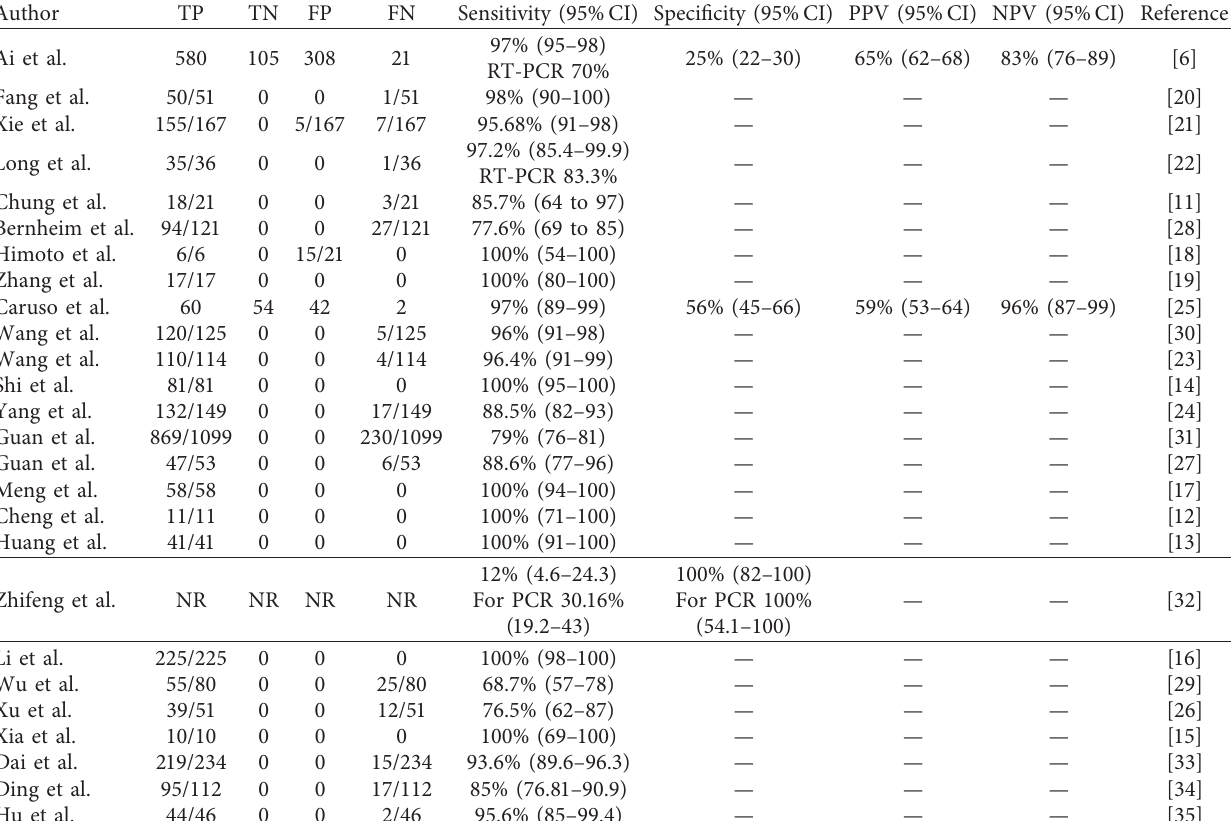
Table 3: Performance of chest CT for COVID-19 infection compared to RT-PCR.